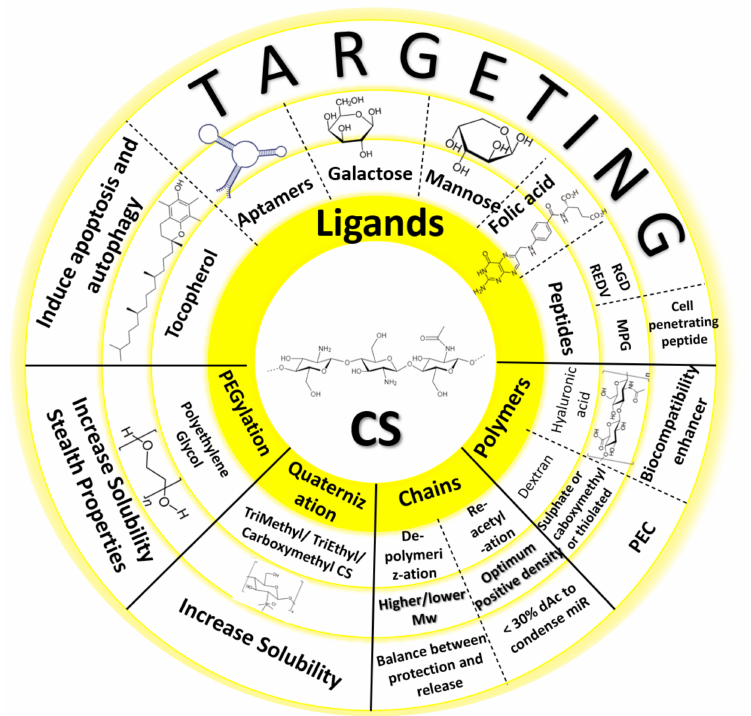
Figure 8. Possible chemical modifications to chitosan in miRNA formulations.